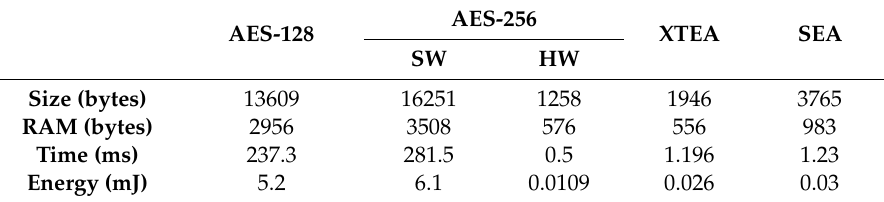
Table 4. Performance comparisons of encryption algorithms on 32-bit microcontrollers.